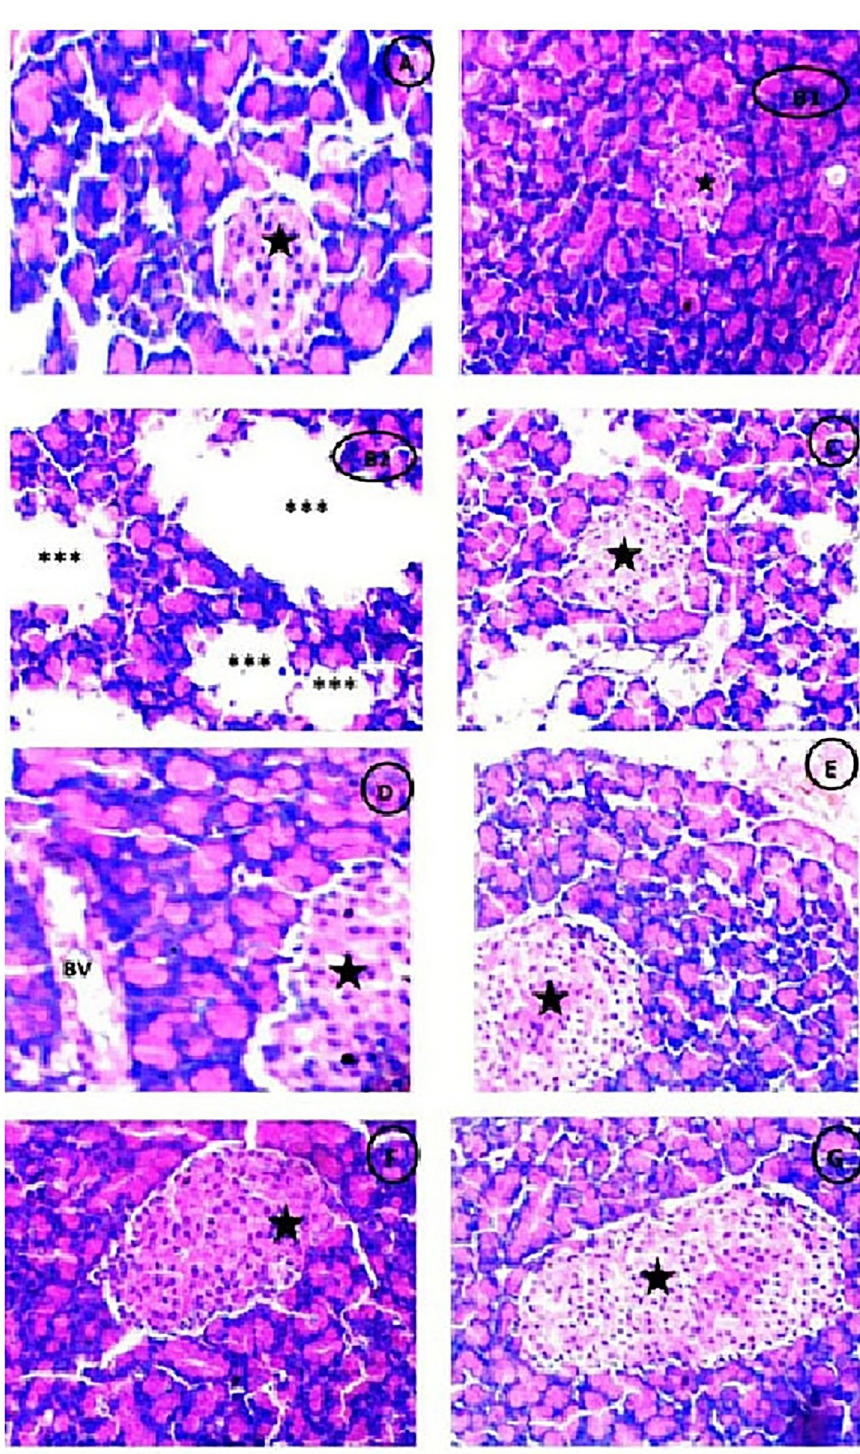
Fig 11. Photomicrograph of Pancreas showing (A) Normal pancreatic parenchyma and normal appearance of Islets of Langerhans (Black star) (H &E X400). (B1,2) STZ treated group showing large detached pancreatic parenchyma ( ��� ) with some parts showing very reduced islets of Langerhans (Black star) (H &E X400).(C) STZ plus stem cell group showing partial restoration of detached pancreatic parenchyma with mild sized islets of Langerhans (Black star) (H &E X400). (D) STZ plus (Q) group showing normal pancreatic parenchyma with appearance of blood vessels (BV)